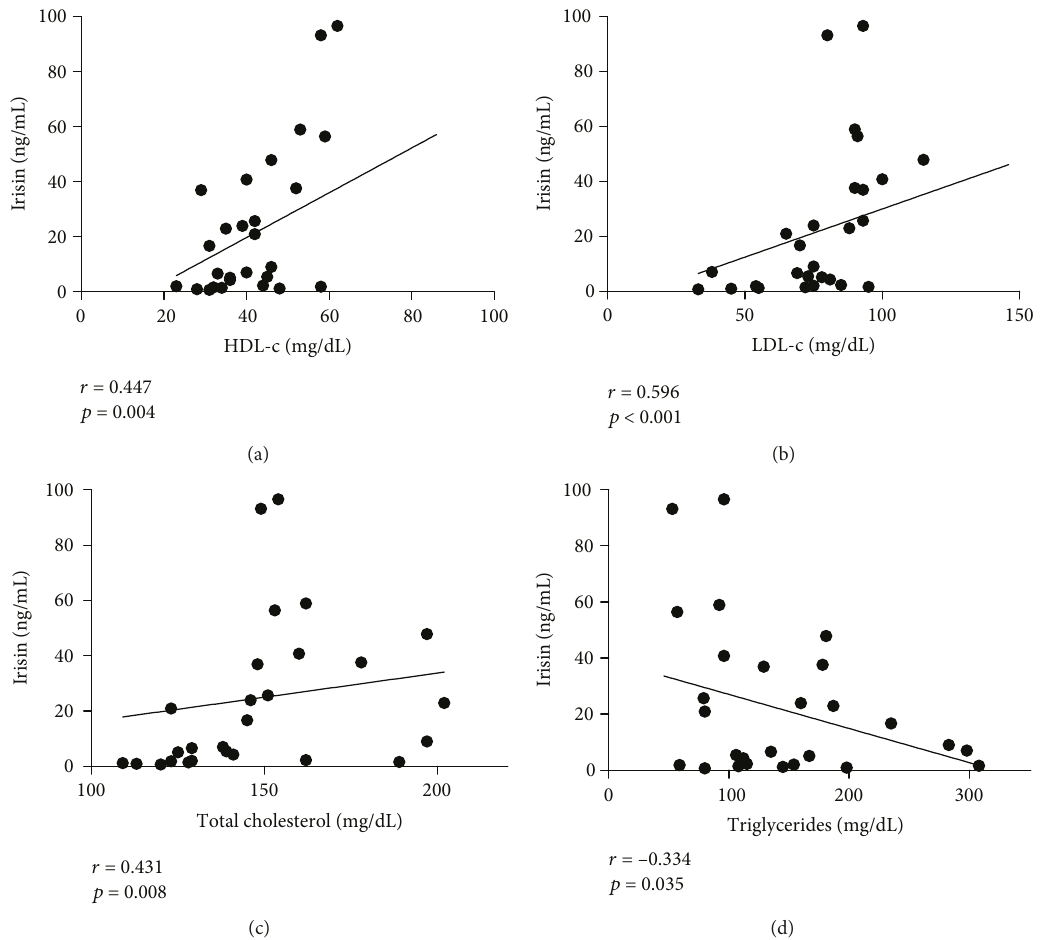
Figure 3: Irisin plasma level correlations with metabolic parameters. Association of plasma irisin levels with high-density lipoprotein cholesterol (a), low-density lipoprotein cholesterol (b), total cholesterol (c), and triglycerides